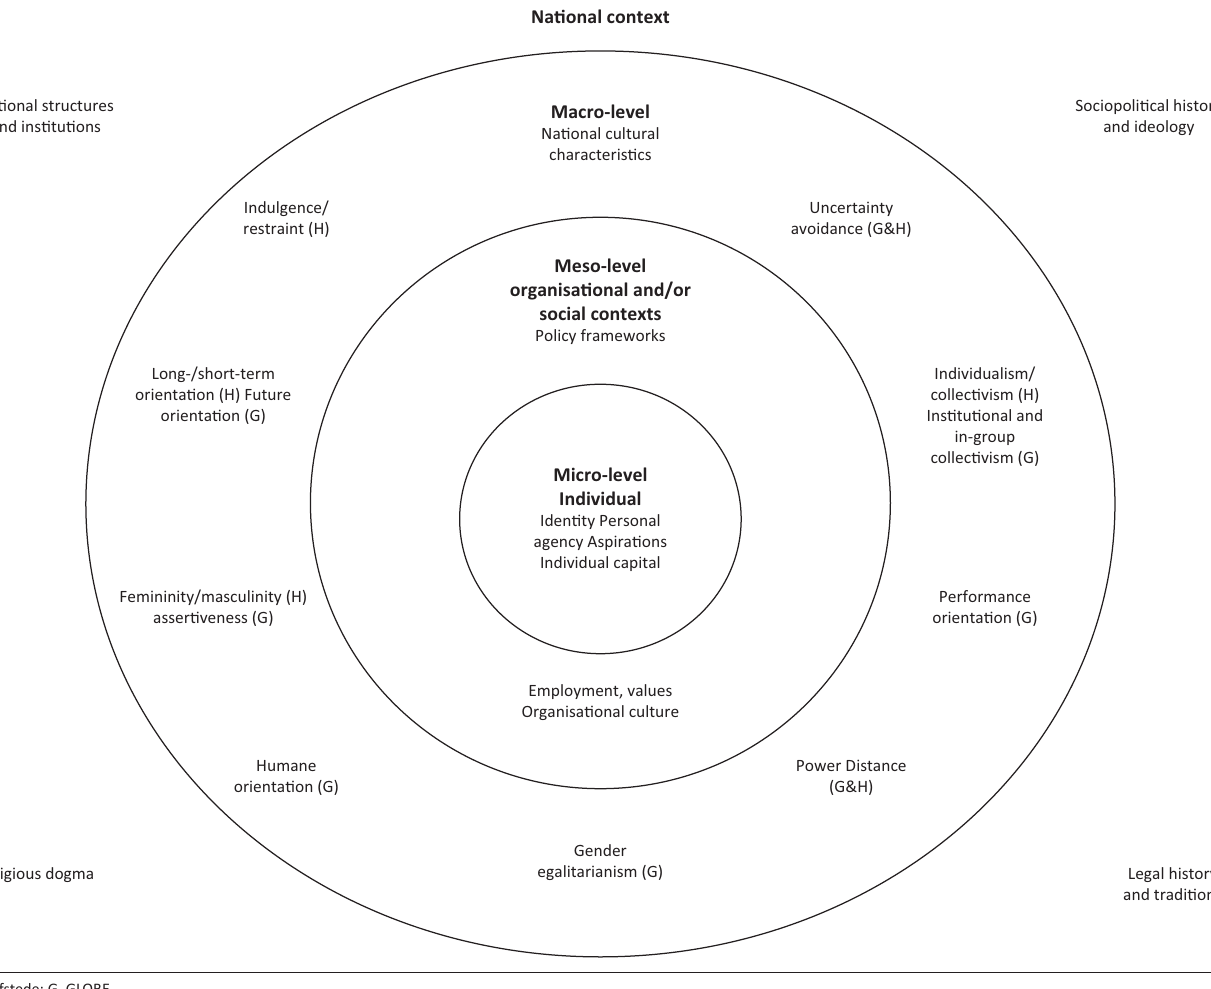
FIGURE 1: A narrowed adaptation of Syed and Ozbilgin’s framework with Hofstede’s six dimensions and the nine GLOBE dimensions